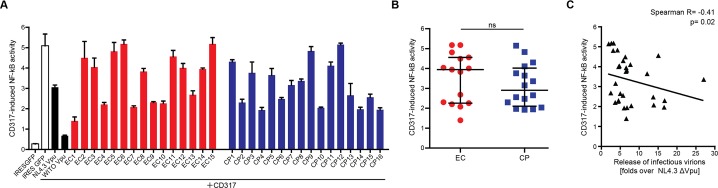
Antagonism of CD317/tetherin-induced NF-kB signaling.
A) CD317/tetherin-induced NF-κB activation by Vpu alleles. Luciferase activity of the NF-κB reporter was determined 40 h post transfection of 293T cells with expression plasmids for CD317/tetherin or filler, the indicated VpuIRESGFP expression plasmids and luciferase reporter plasmids. HIV-1 NL4.3 Vpu and HIV-1 M WITO Vpu served as controls. Mean values of 6–9 transfections are shown with the indicated standard deviation. B) Effect of EC and CP Vpu alleles on CD317/tetherin-induced NF-κB activation. Statistical significance was assessed using two-tailed Mann-Whitney U-Test (p = 0.29), bars represent median and interquartile ranges. C) Correlation of Vpu-mediated inhibition of CD317/tetherin-induced NF-κB activity and release of infectious virions. Statistical analyses were done using Spearman’s correlation.